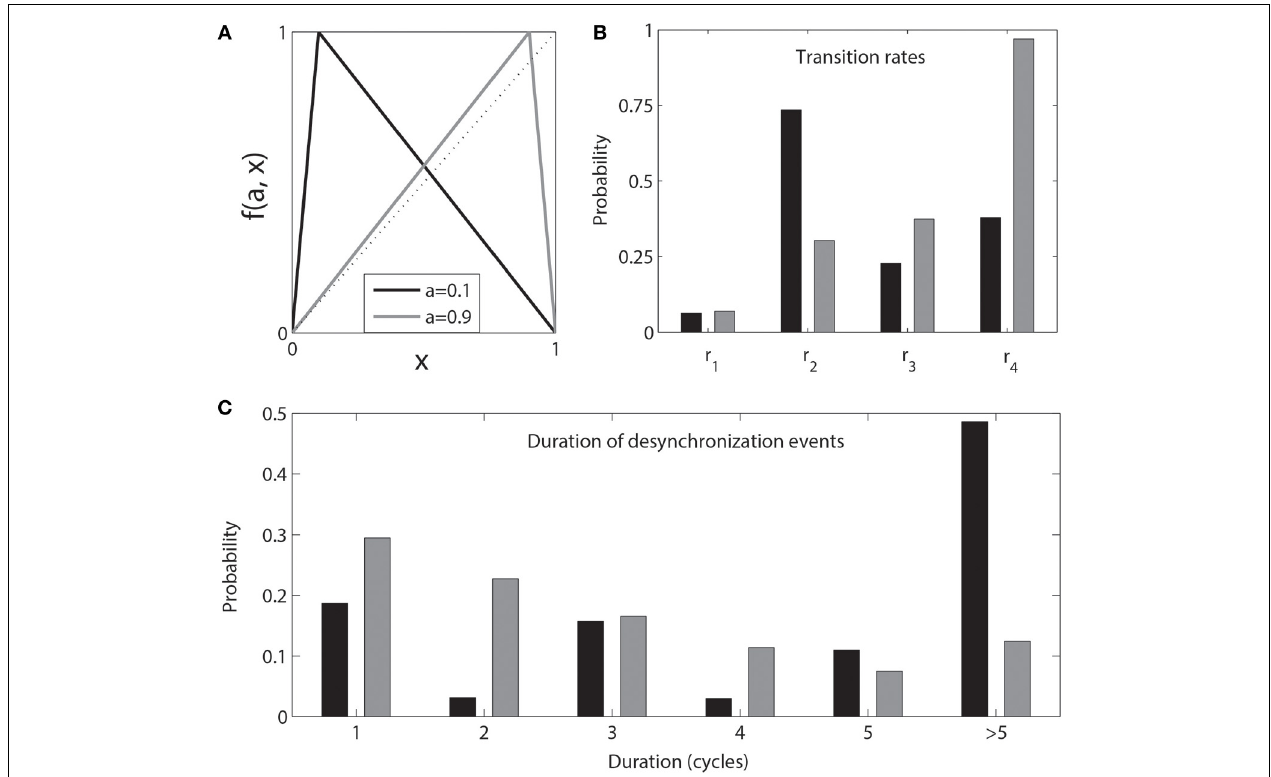
but different expansive/contractive properties in different areas of the phase space. (A) the maps, (B) transition rates, and (C) distribution of durations of desynchronization